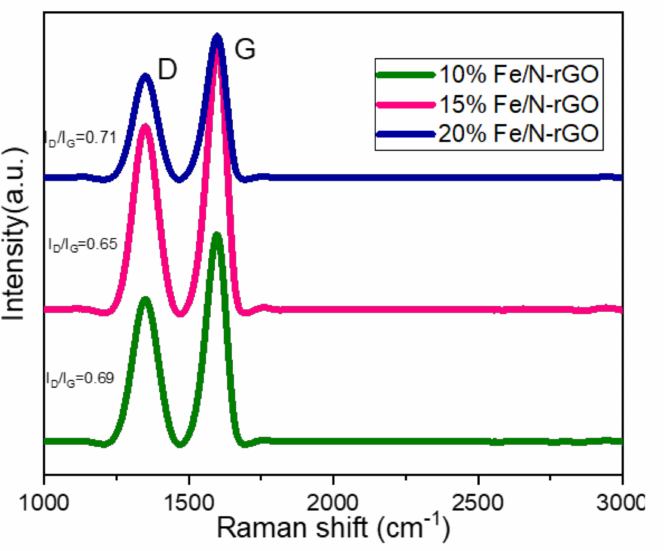
Figure 2. Raman spectra of D and G bands of 10% Fe/N-rGO, 15% Fe/N-rGO and 20%